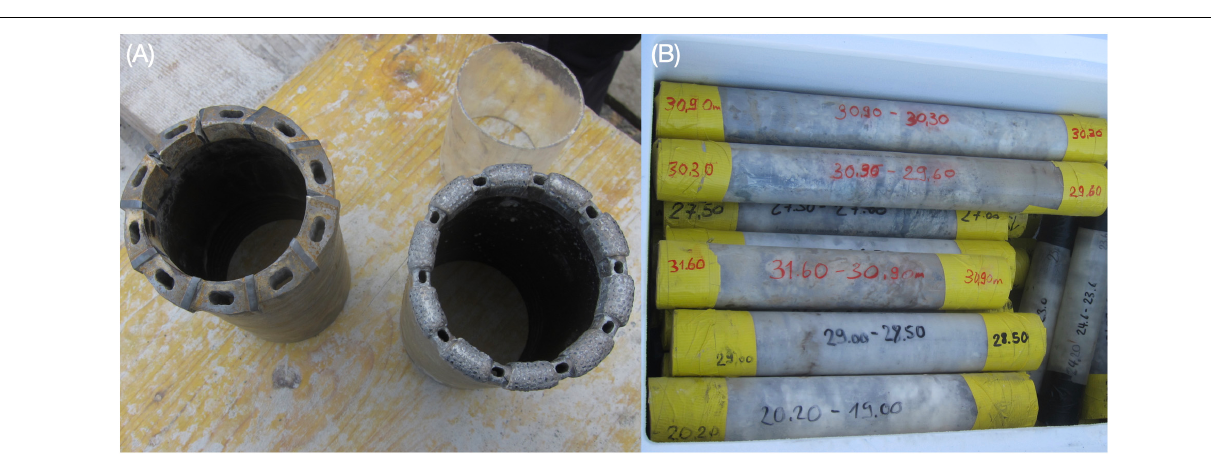
FIGURE 5 | Drill bits (A) and cores (B) taken in the Murtèl-Corvatsch rock glacier between 5 and 30 m depth. The samples consist of nearly pure ice and were stored in a freezer on the drill site before transport to the cold laboratory. Photos: J.